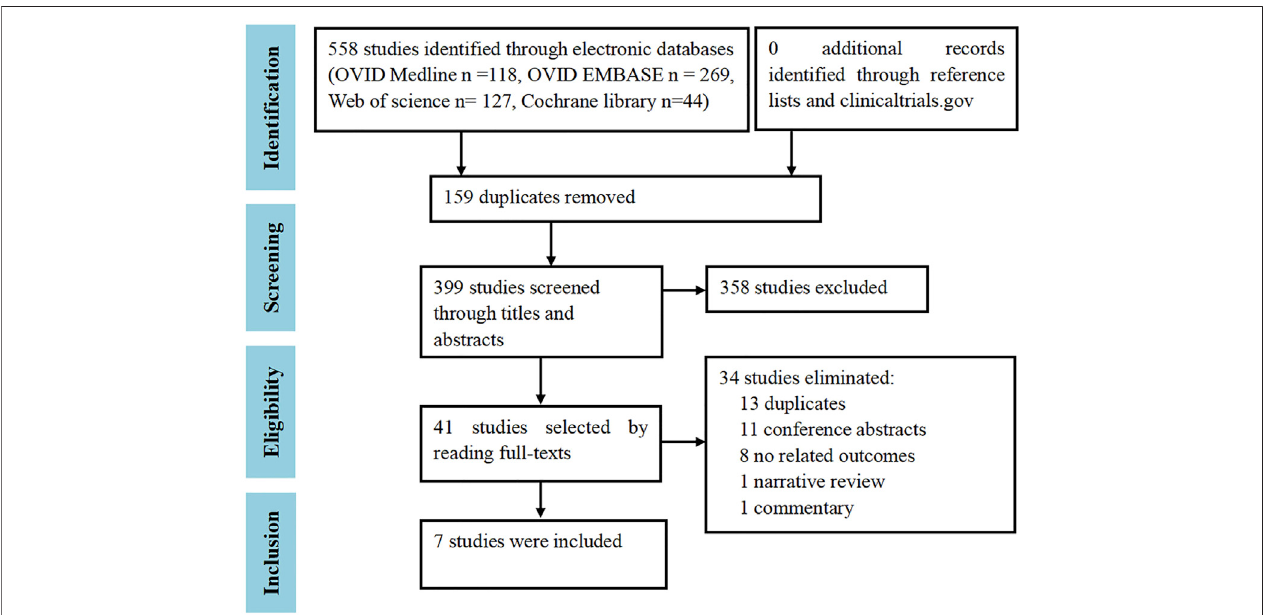
FIGURE 1 | Study selection fl owchart. Adapted from Chen et al.